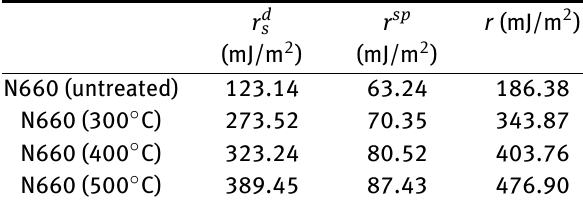
Table 5: Effect of heat treatment on surface free energy of CB